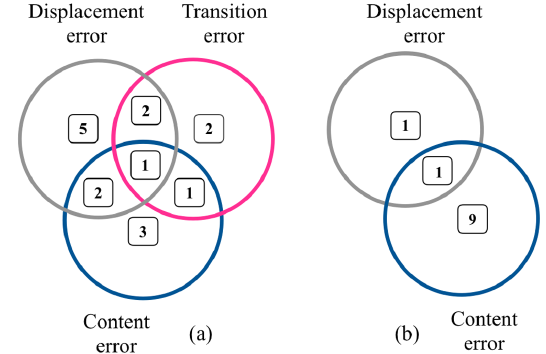
FIG. 7. The number of difficulties mapped to error categories, a) for questions that require shifting, b) for questions that do not require shifting.